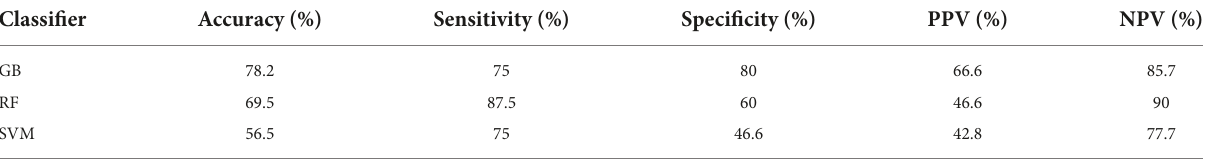
TABLE 2 Classification performance of three different classifiers using a subset of optimal features, extracted from rs-fMRI using AAL atlas. Classifier